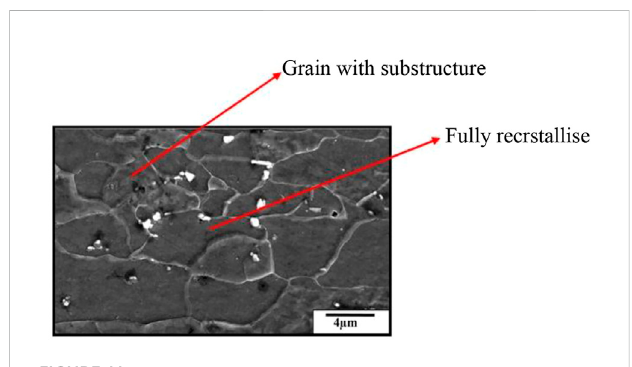
FIGURE 11 SEM micrograph of substrates.